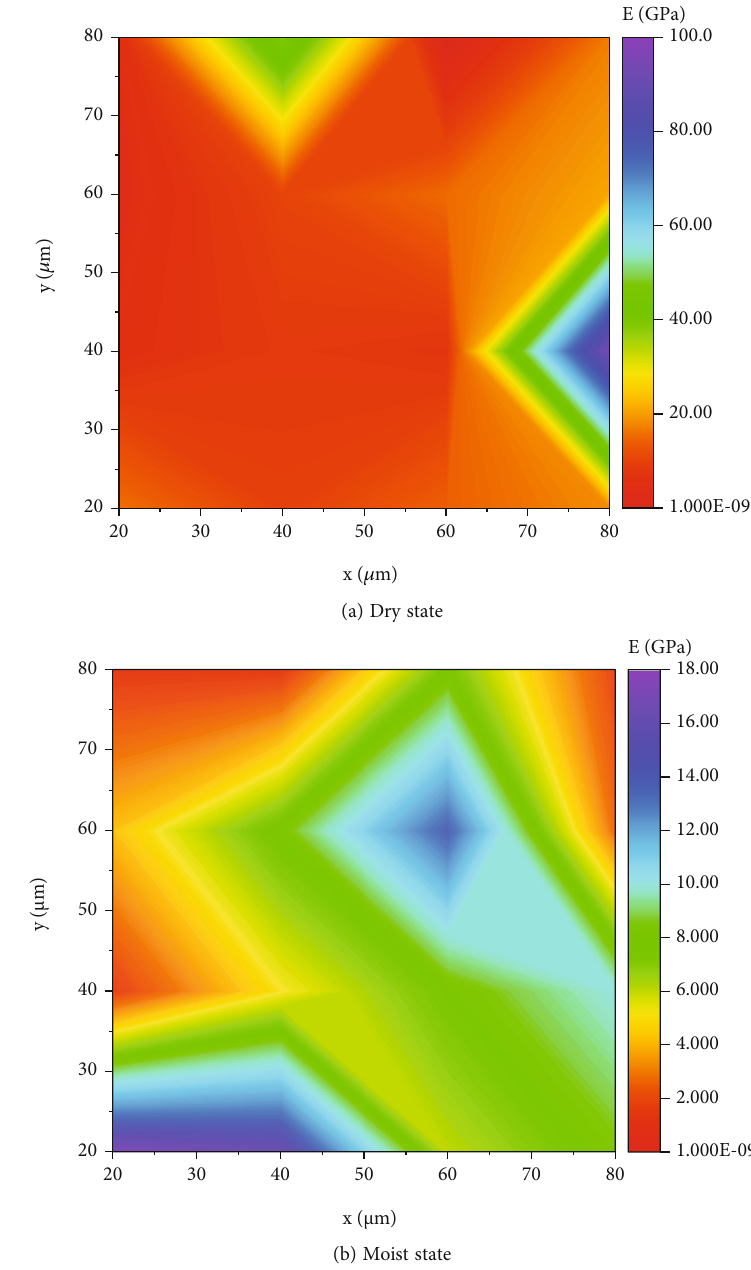
Figure 10: Contour of surface elastic modulus variation of the dry and the moist